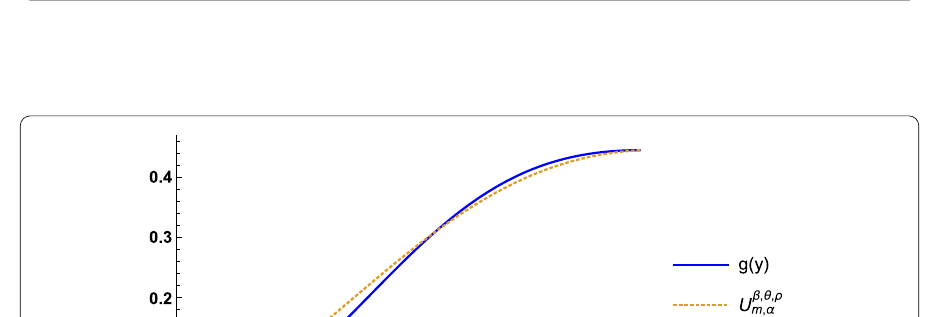
Figure 2 Comparison of operators